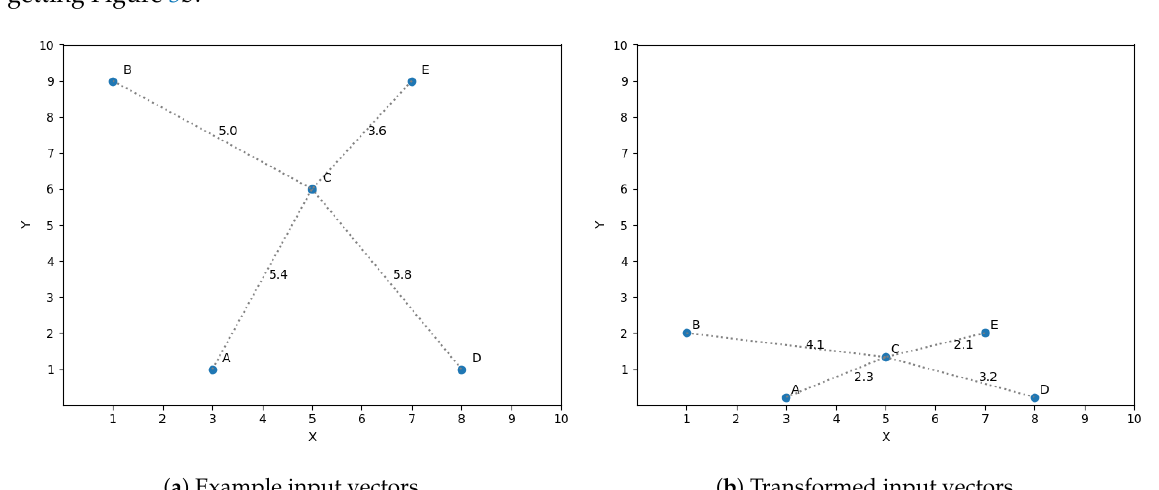
Figure 3. Feature